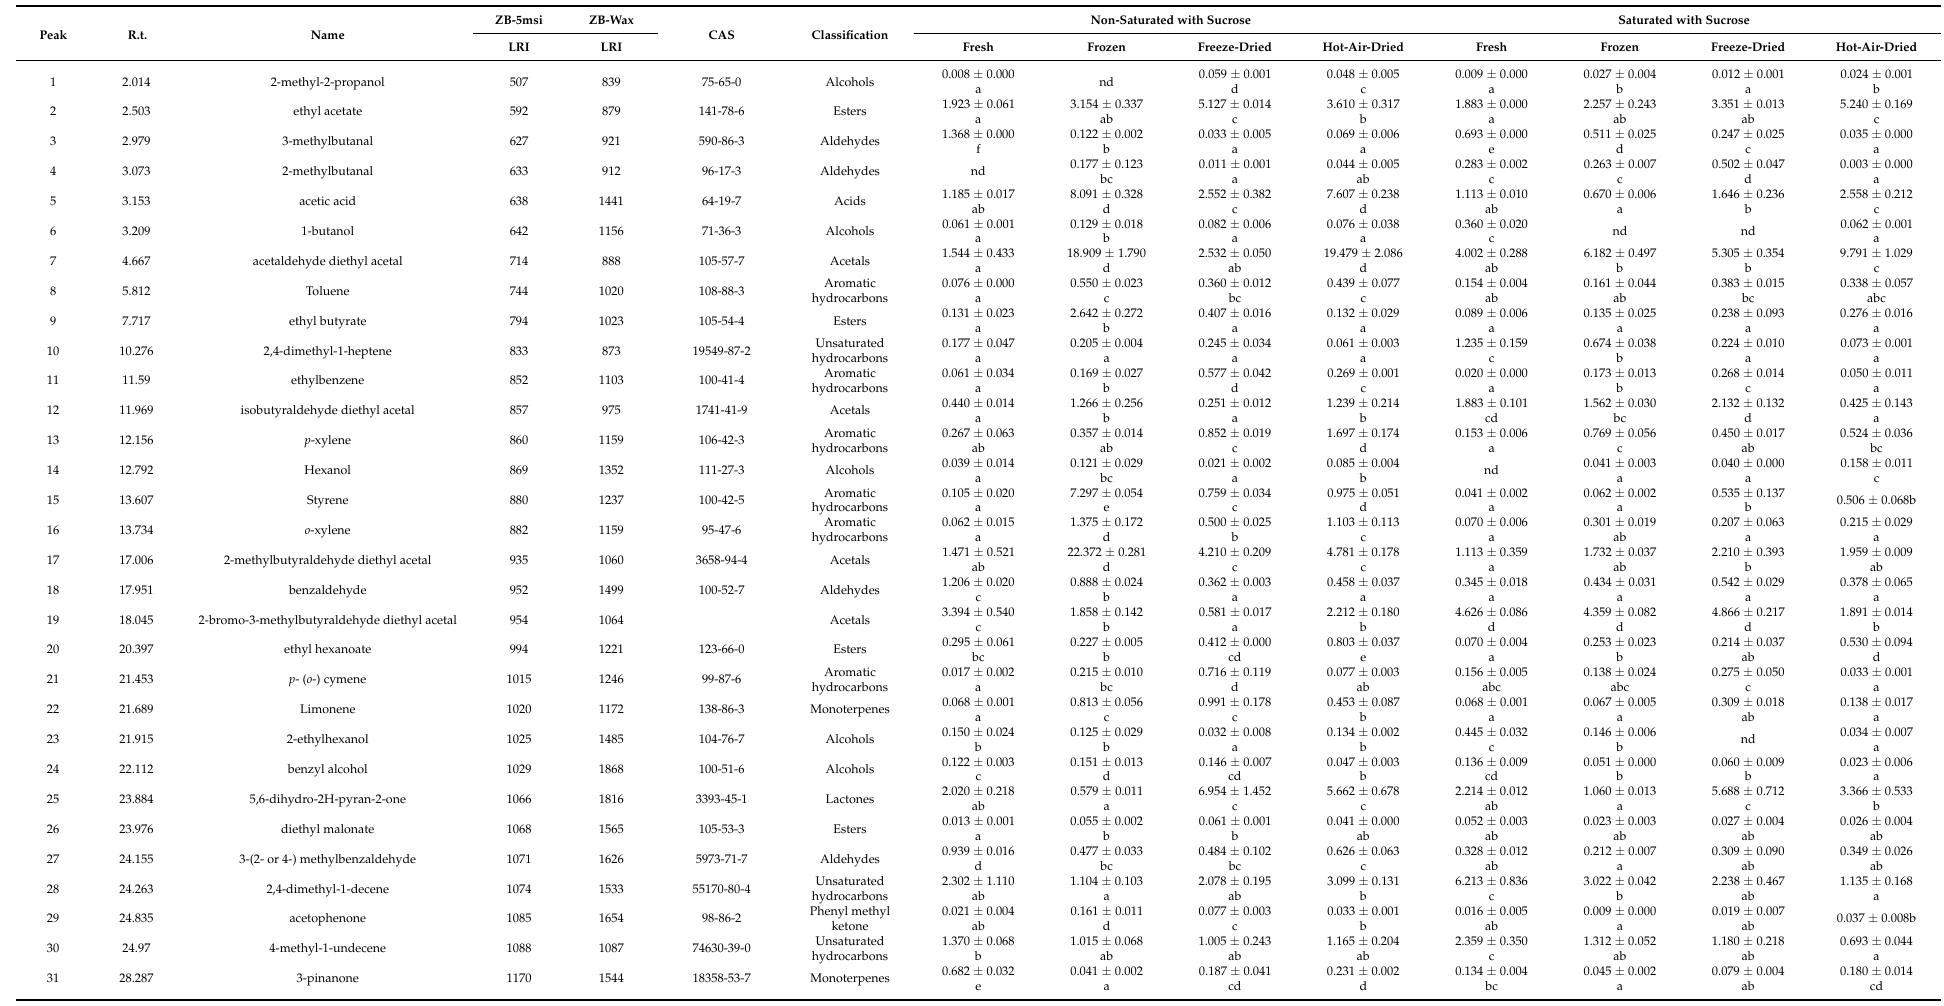
Table 1. The content of identified volatile compounds (g · 100 g − 1 ) with their classification into chemical groups in the liqueurs prepared from hawthorn pseudo-fruits as affected by the sucrose saturation and preservation method (Mean ±